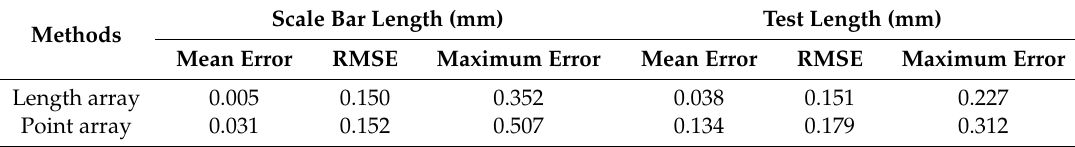
Table 8. Length measurement errors of the two methods.